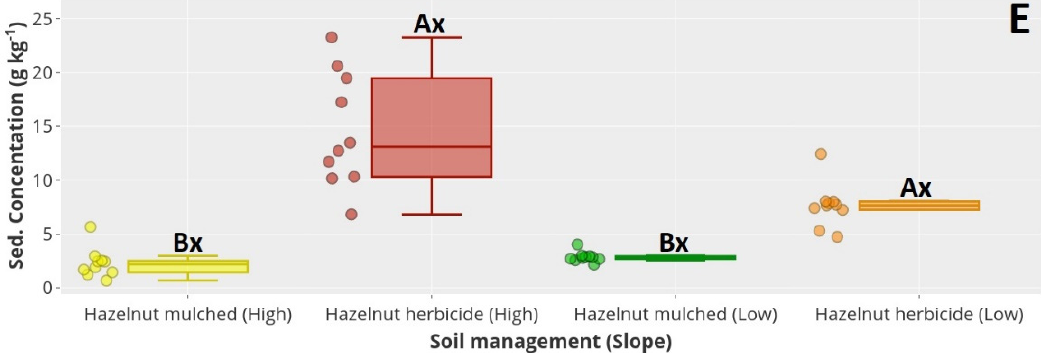
Figure 5. ( A ) Time to ponding (PT), ( B ) time to runoff (RT), ( C ) infiltration rate (RT), ( D ) water runoff (Run), ( E ) sediment concentration (SC) distribution according to the soil management and slopes. Upper hanging bar (high edge), lower hanging bar (low edge), upper box line (third quartile), line (median), and lower box line (first quartile). Different uppercase letters (A, B) represent significant differences between soil managements ( p < 0.05). Different lowercase letters (x, y) represent significant differences between slopes ( p < 0.05).